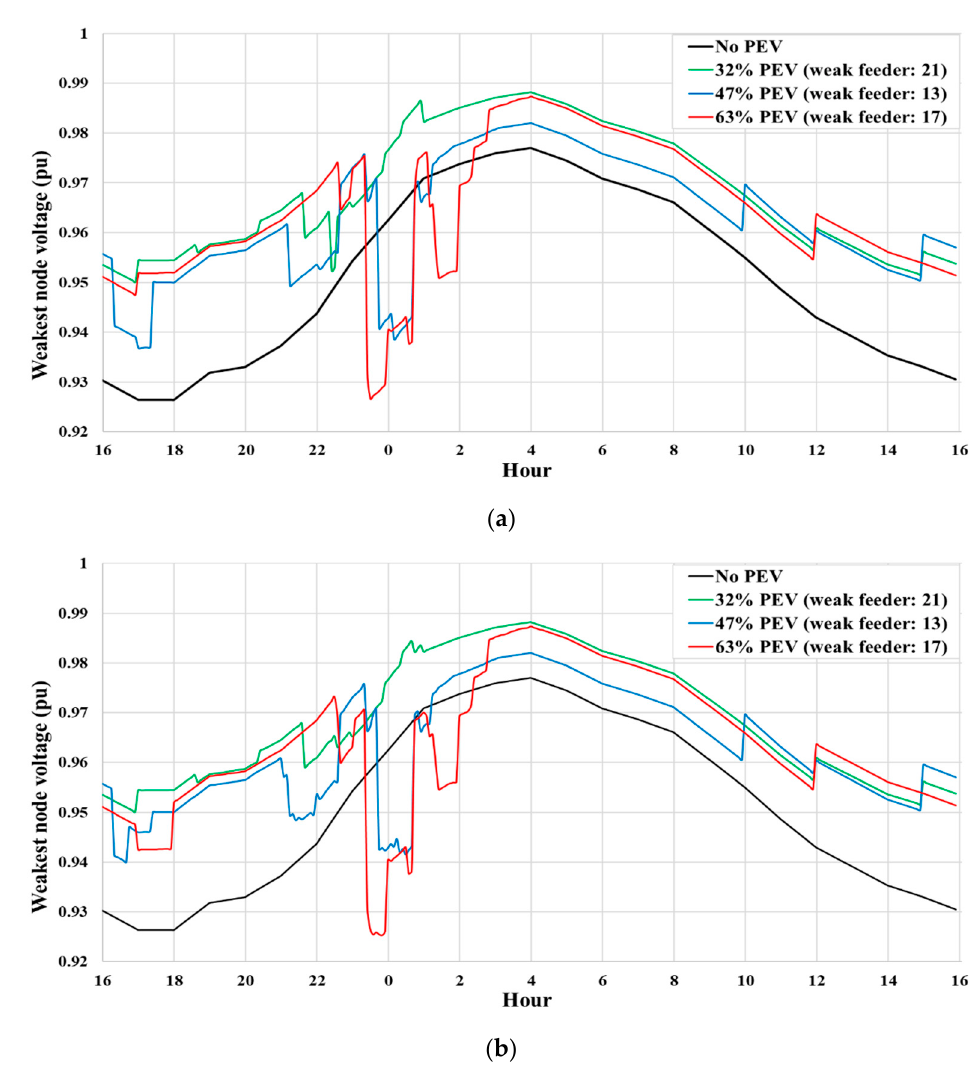
Figure 5. Profile for the weakest node with capacitor switching and OLTC adjustment during PEV charging coordination using ( a ) BPSO and ( b ) BGWO.